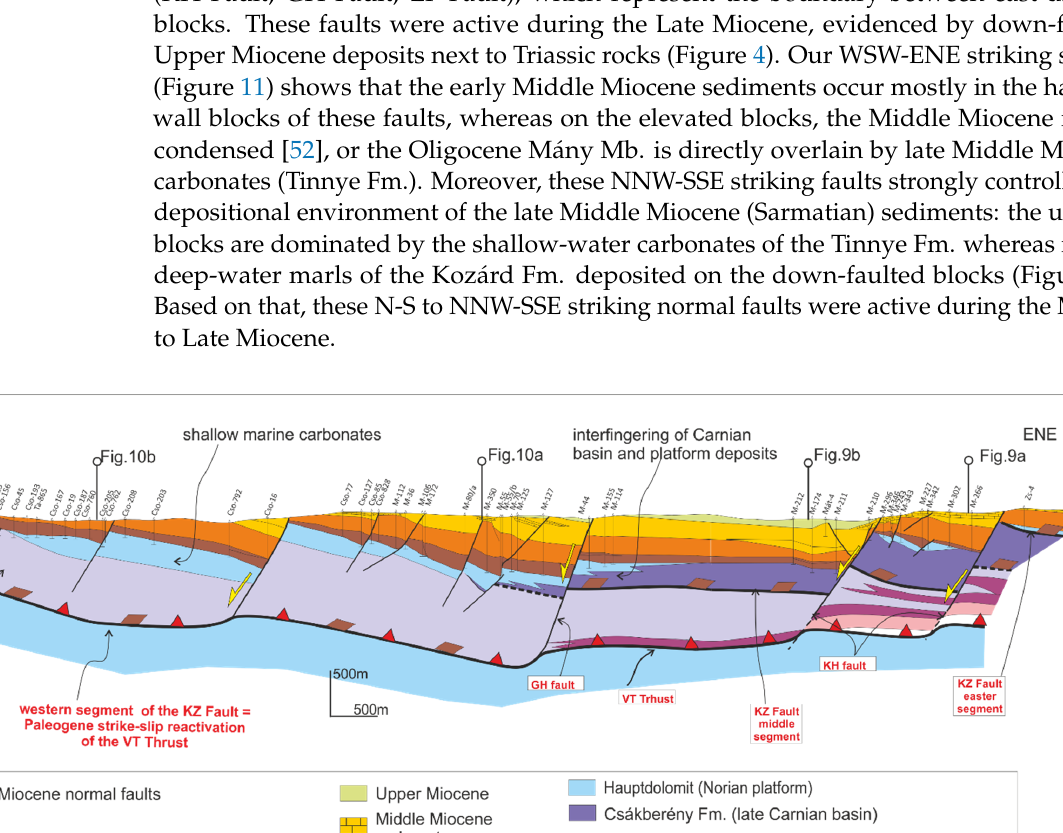
Figure 10. Sections across the western segment of the KZ Fault. ( A ) Section across the eastern part of the western segment of the KZ Fault. ( B ) Section across the western part of the western segment of the KZ Fault. For the location of the section, see Figure 4. The abbreviations “Fig.” refer to figures of this work.